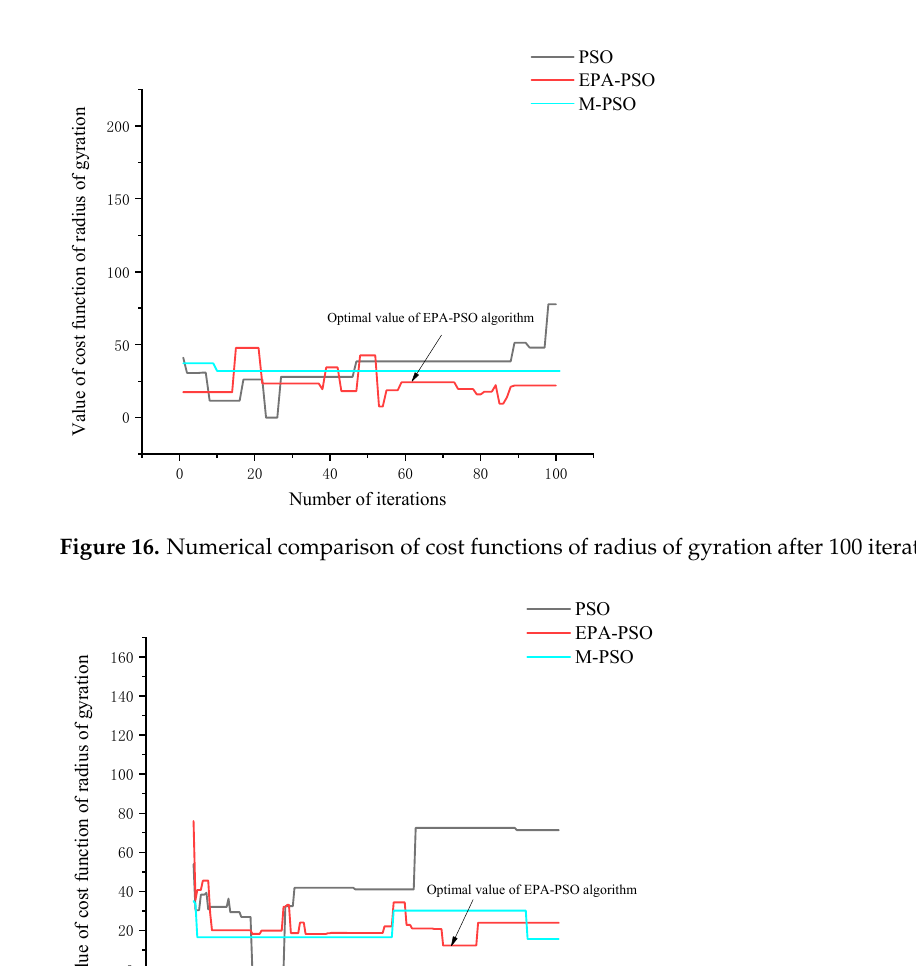
Figure 15. Numerical comparison of energy cost functions after 500 iterations.